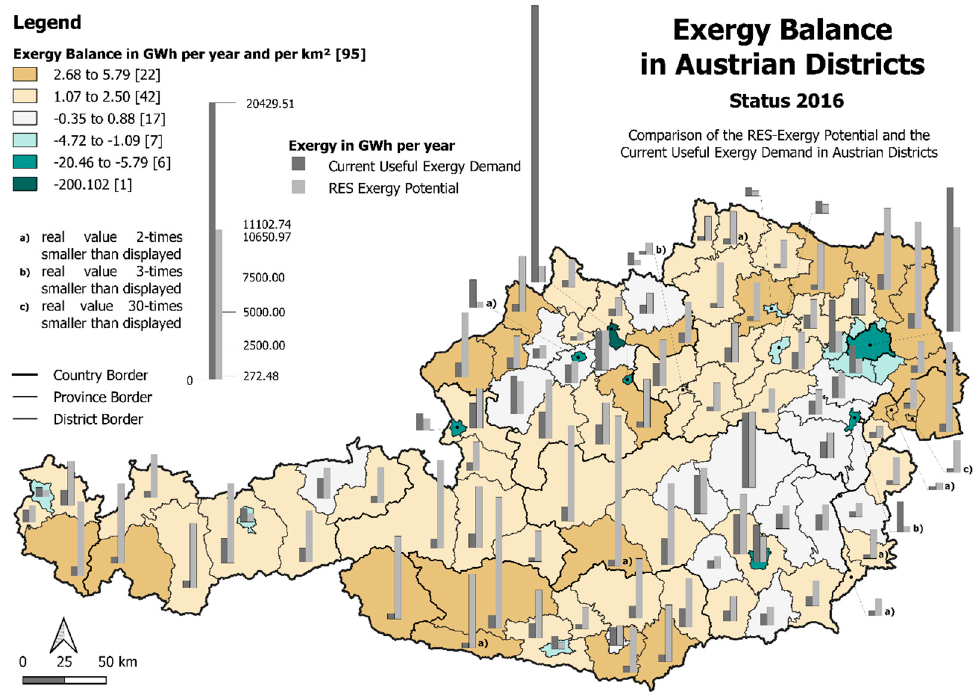
Figure 15. Exergy balance in Austria per district calculated by the exergy potential of RES minus the current useful exergy demand. One can see that in this comparison nearly all districts of Austria have a positive balance or are nearly balanced (map source: Statistics Austria—data.statistik.gv.at).